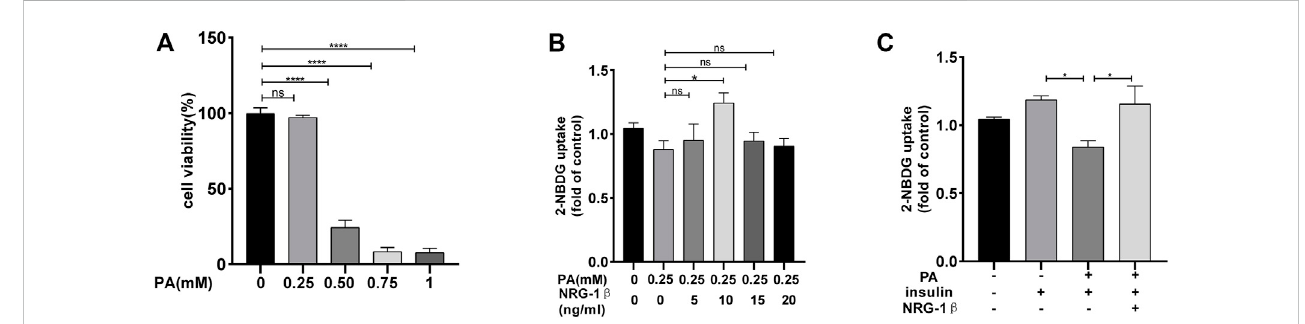
FIGURE 1 NRG-1 β increasedglucoseuptakeinPA-treatedC2C12myotubes.C2C12myotubeswereincubatedwithdifferentconcentrationsofPAfor24 handcell viability measured using the CCK8 assay (A) . C2C12 myotubes were serum depleted for 4.5 h and then incubated for 1.5 h with different concentrations of NRG-1 β (0,5,10,15,and20 ng/mL) (B) .C2C12myotubeswereincubatedinthepresenceorabsenceoftheindicatedconcentration(10 ng/mL)ofNRG-1 β for 1.5 h, the cells were incubated with 80 μ M 2-NBDG for 30 min. The 2-NBDG uptake was determined as described in the Methods (C) . The data are presented as the mean ± SEM. ns, p > .05; * p < .05; **** p < .0001.